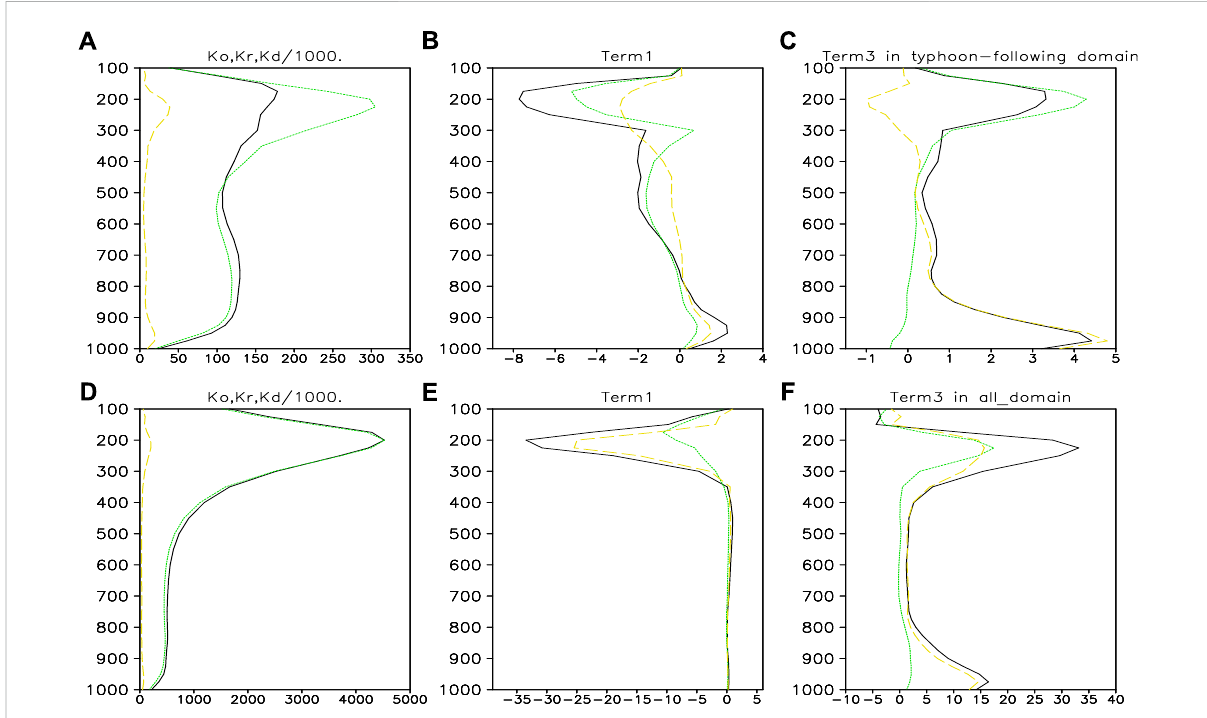
FIGURE 7 (A) K0 (black), Kr (green), and Kd (yellow); (B) T1 (black), T1r (green), and T1d (yellow), and (C) T3 (black),T3r (green), and T3d (yellow) by hybrid method averaged over the entire ET process in the TC following domain. (D – F) are corresponding all